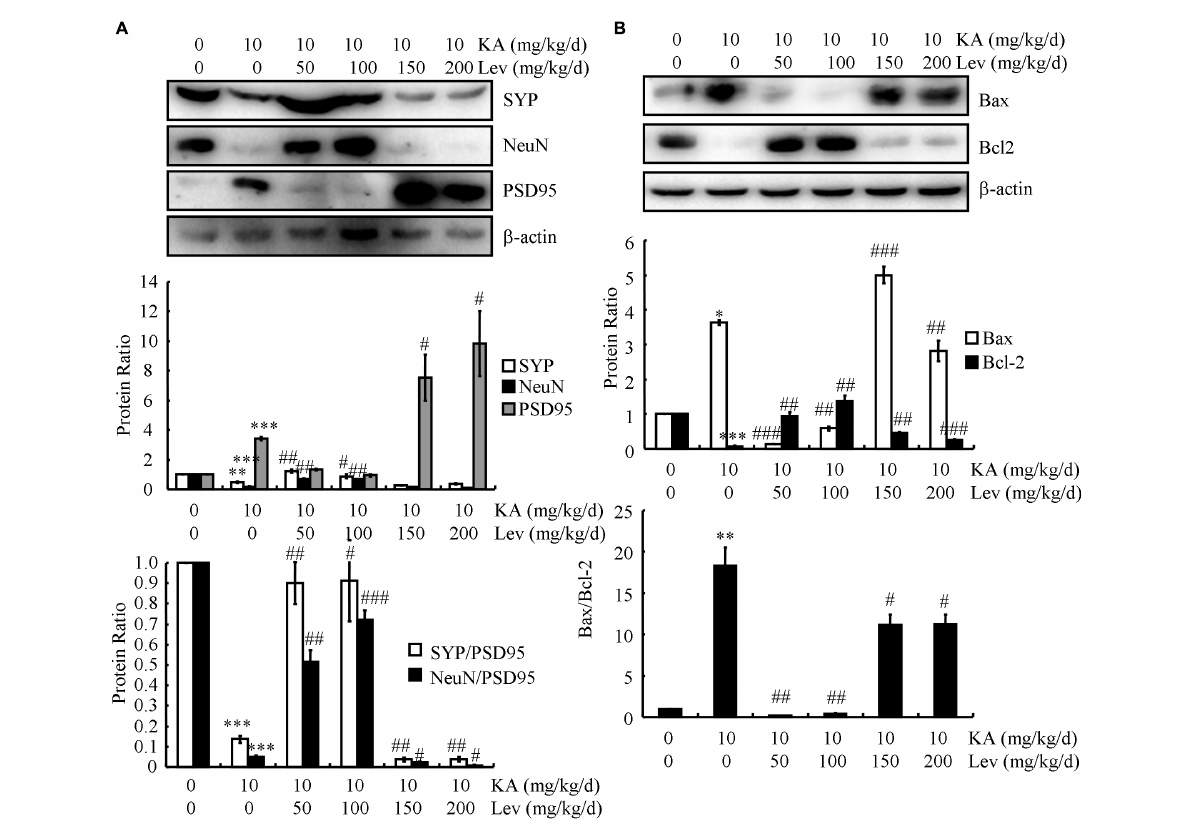
FIGURE6 Low doses of LEV protect neurons from neuronal loss, whereas high doses of LEV induce the apoptosis of neurons. (A,B) The protein levels of SYP, NeuN, PSD95, Bax, and Bcl2 were determined in the brains of KA (10 mg/kg)- or LEV (50, 100, 150, or 200 mg/kg)+KA-treated APP23/MAPT mice, as determined by western blots. The optical densities of bands in the western blots were evaluated using ImageJ software (* P < 0.05; ** P < 0.01; and *** P < 0.001 vs. the control group; # P < 0.05; ## P < 0.01; and ### P < 0.001 vs. the KA-only group). KA, kainic acid; LEV,